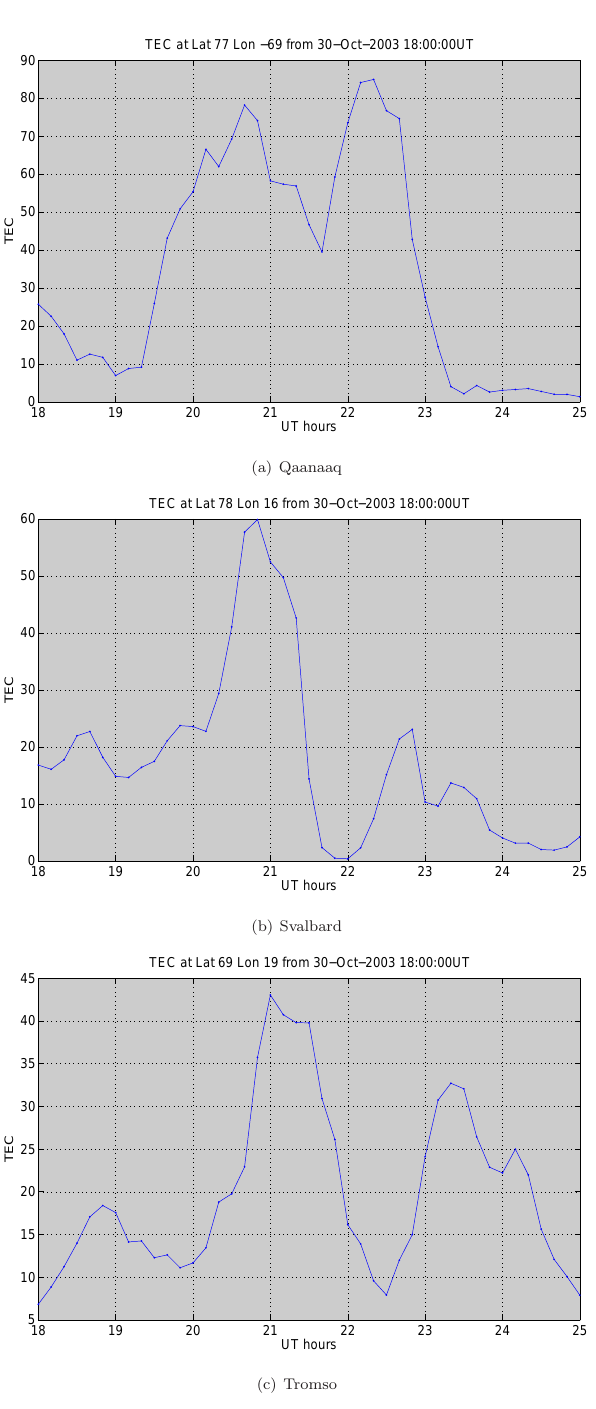
Fig. 7. GPS TEC variations (in TECu) from 18:00UT 30 October to 01:00UT 31 October for three locations: (a) Qaanaaq, (b) Svalbard and (c) Tromsø.